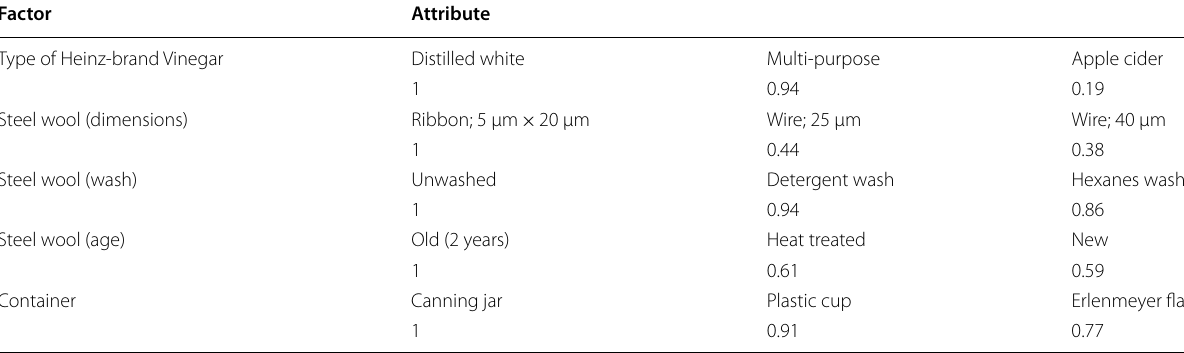
Uncertainties estimated to be